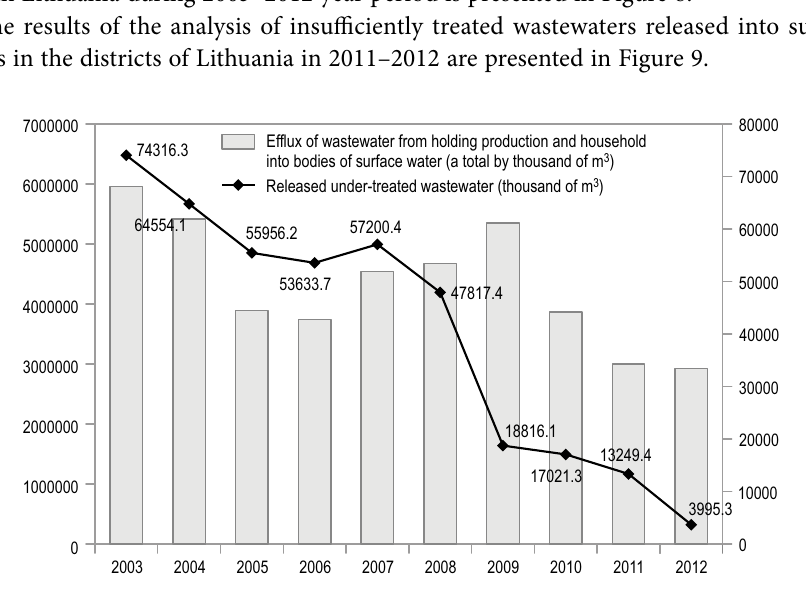
Fig. 7. The wastewater discharges from farms and household production into surface waters in the districts of Lithuania during 2003–2012 years